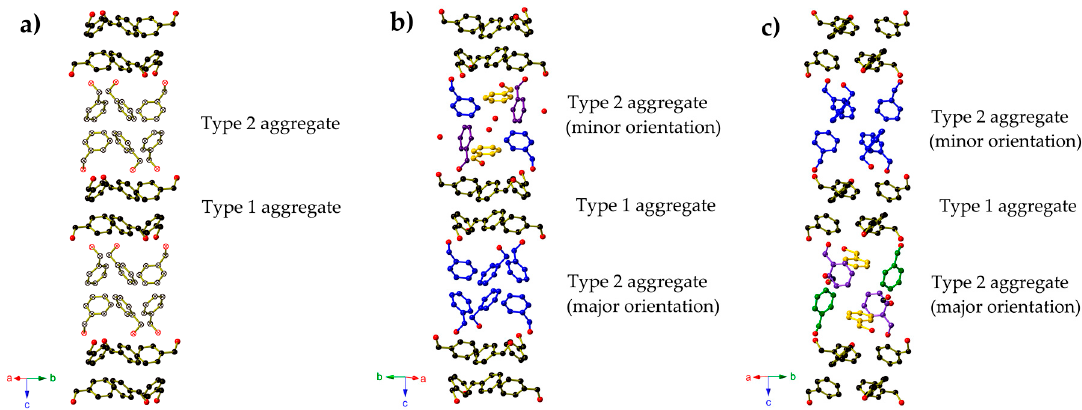
Figure 3. Views of the interactions between benzyl groups that occur in ( a ) Co 2 (BzOip) 2 (H 2 O) prepared in aqueous iso propanol; ( b ) Co 2 (BzOip) 2 (H 2 O) · 0.19H 2 O prepared in aqueous ethanol; ( c ) Co 2 (BzOip) 2 (H 2 O) · 0.29H 2 O · 0.29MeOH prepared in aqueous methanol. In all cases, the benzyl groups shown in black are well ordered and participate in a hexaphenyl embrace. In ( b ) and ( c ), the benzyl groups shown in blue also participate in a hexaphenyl embrace. The hexaphenyl aggregate shown using hatched atoms in ( a ) is fully ordered in the crystals obtained from iso propanol, but disordered in the crystals obtained from methanol or ethanol.